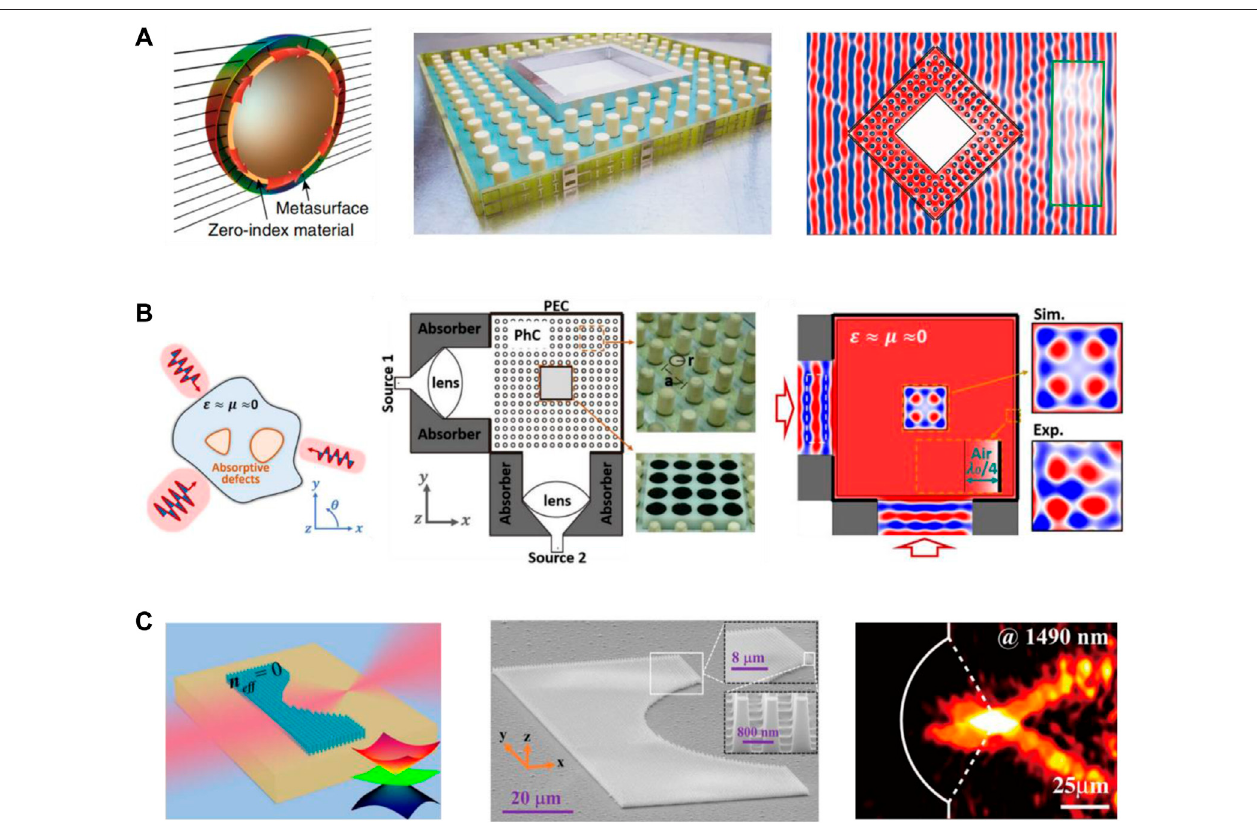
FIGURE 2 | (A) Left: schematic graph of a hybrid invisibility cloak based on the integration of metasurfaces and ZIM. Middle: picture of the fabricated microwave cloakingshell,whichconsistsofametasurfaceandaPhCwithaDirac-likecone.Rightpanelshowstheelectric- fi elddistribution.Thepartinsidetheregionmarkedbythe green rectangle is measured in the experiment, and the other part is obtained by simulations. Reproduced with permission from Ref. [64]. (B) Left: illustration of the geometry-invariantcoherent perfect absorberby using impedance-matched ZIM doped withabsorptivedefects. Middle panel shows the microwave experimental setup.AdielectricPhCwithaDirac-likeconeisutilizedtoworkasaneffectiveimpedance-matchedZIM.Rightpanelshowsthemeasuredelectric- fi elddistributionatthe Dirac-pointfrequency.ReproducedwithpermissionfromRef.[59]. (C) Left:schematicviewofaplane-concavelensmadeofZIM.Middle:scanningelectronmicroscopy image of the fabricated lens consisting of silicon nanopillars on a silicon substrate. Right: optical microscope images of two incoherent beams passing through the lens, showing the focusing behavior at 1490 nm. Reproduced with permission from Ref.